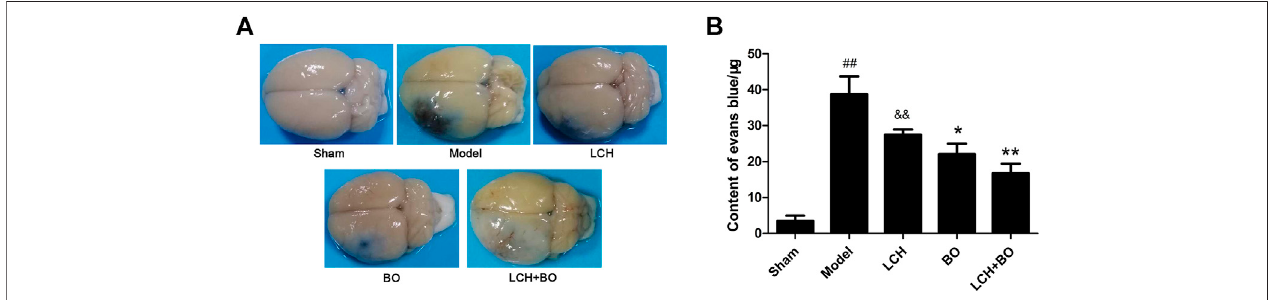
FIGURE 7 | BBB permeability evaluation of MCAO rats. (A) Representative brain pictures after the injection of Evans blue. (B) The contents of Evans blue in the brainsofMCAOrats( n (cid:1) 6). ## p < 0.01comparedtothesham group;* p < 0.05, ** p < 0.01comparedtothemodel group; && p < 0.01comparedtotheLCH +BOgroup.